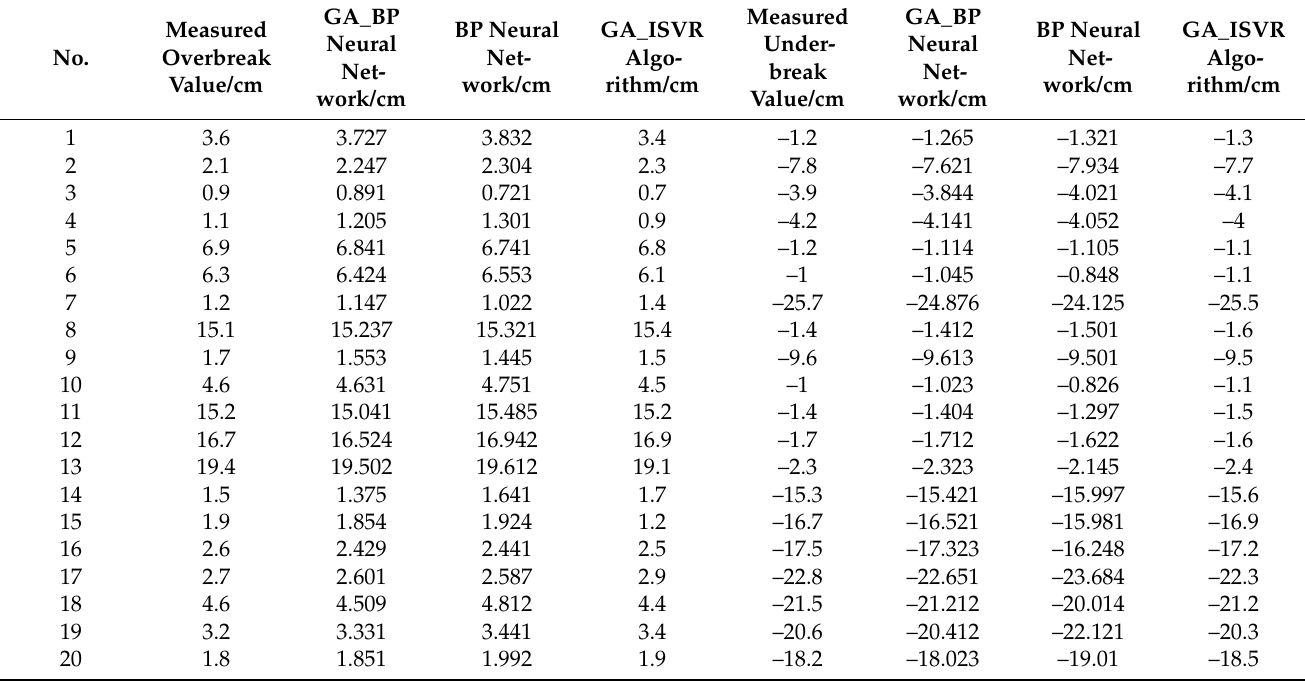
Table 9. Comparison between actual overbreak/underbreak values and predicted values by various